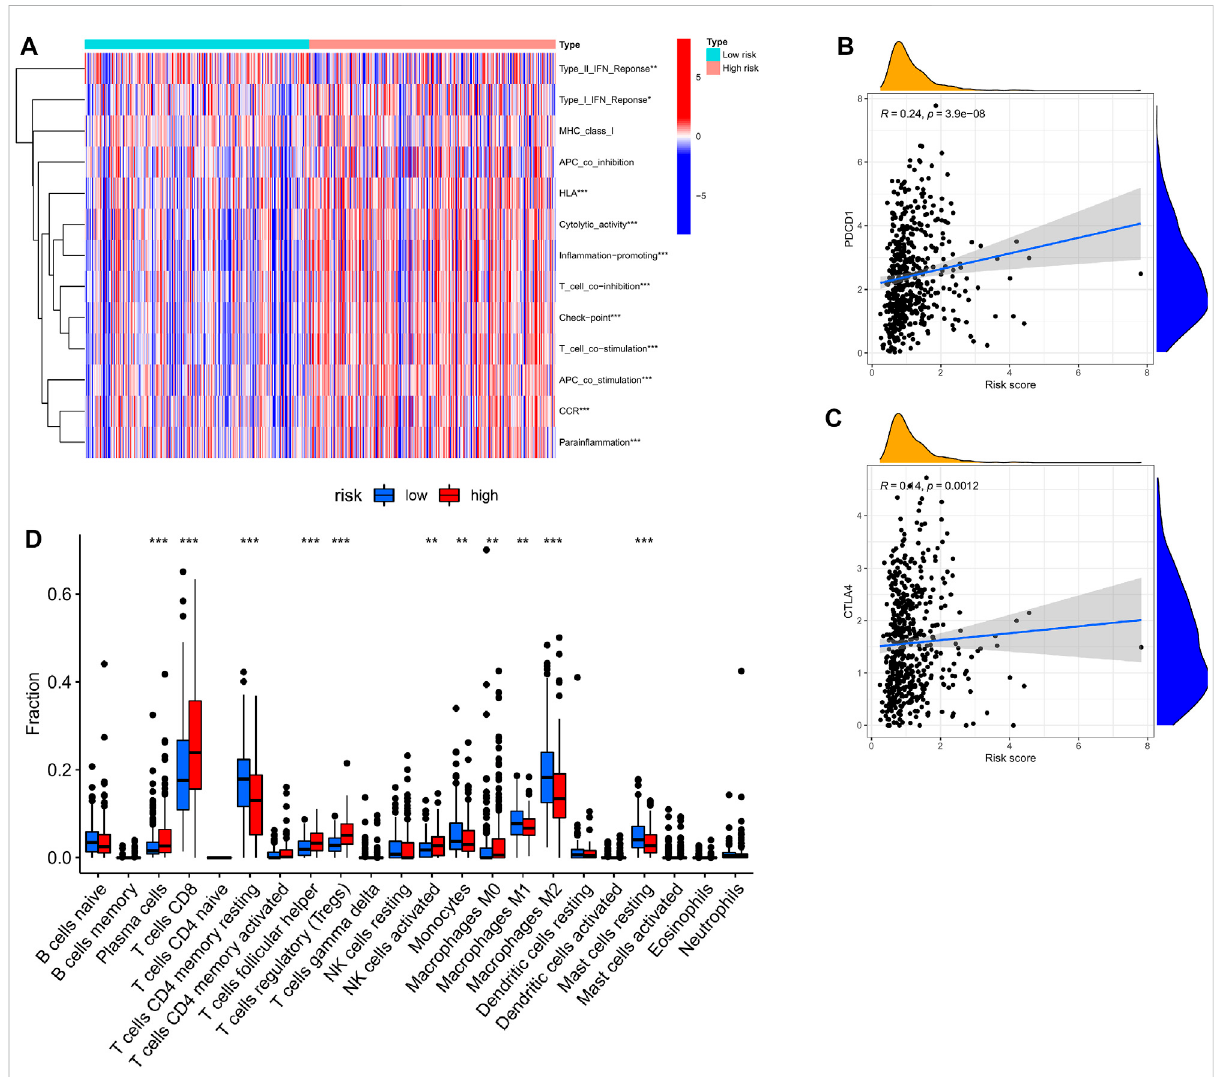
FIGURE 6 Correlation of CRGs signature with immunity. (A) Heatmap of the scores of immune-related functions between different risk groups. (B,C) The associationbetweenriskscoreandexpressionofPDCD1orCTLA4 (D) Boxplotscomparingthescoresofimmunecellsbetweendifferentriskgroups. * p < 0.05; ** p < 0.01, *** p <